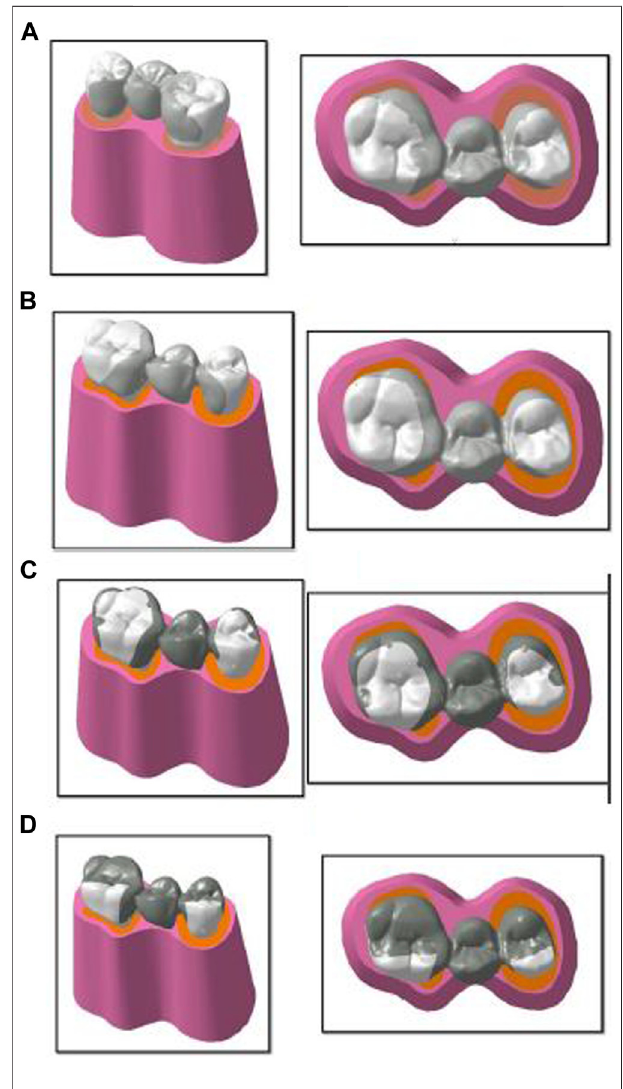
FIGURE 1 | Geometry creation of four designs: (A) design 1 with lingual wings and occlusal rests; (B) design 2 with wings and proximal slices; (C) design 3 with wings, rests, and grooves; and (D) design 4 with wings, rests, grooves, and occlusal coverage used for fi nite element analysis.